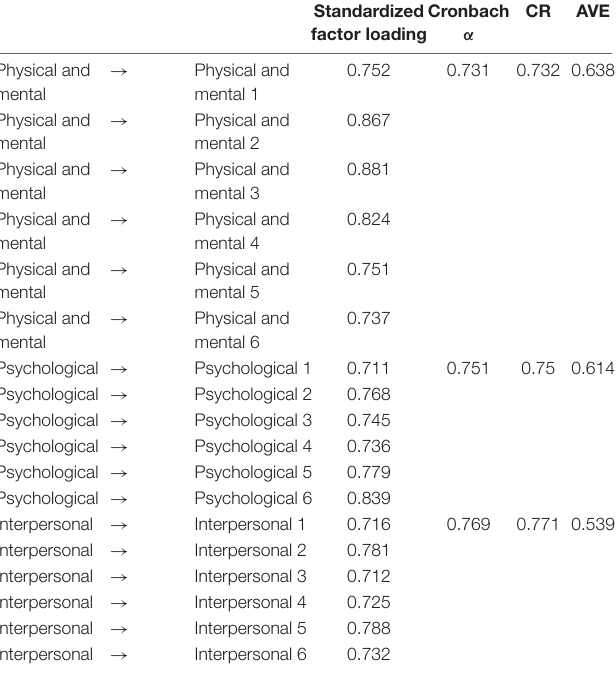
TABLE 6 | Scale information table.